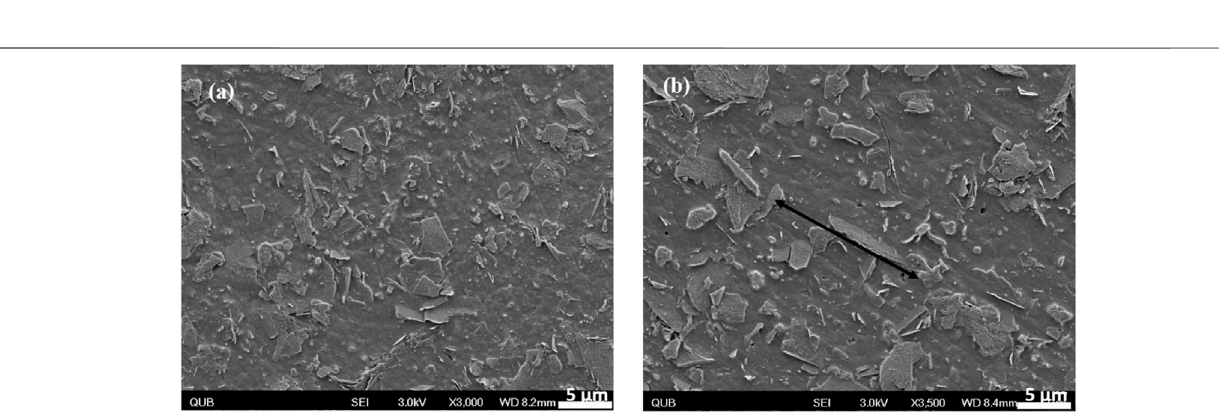
Frontiers in Materials |